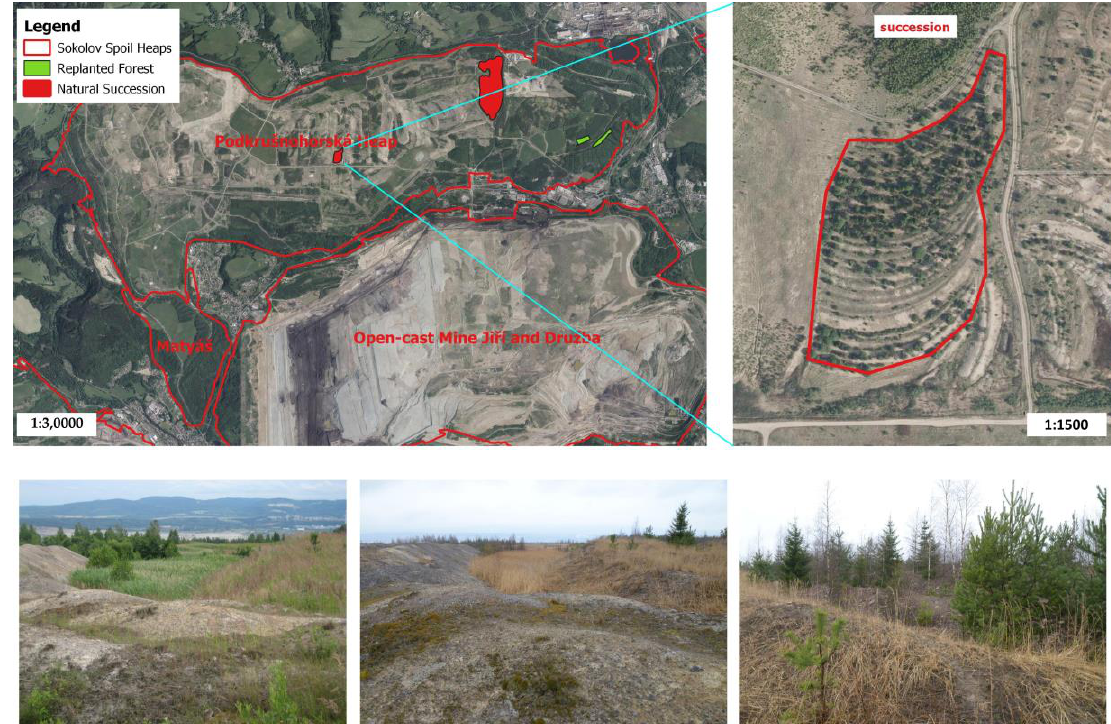
Figure 2. Geographical localization of unreclaimed sites on the Podkrušnohorská heap with and the visualization of wave-like terrain.